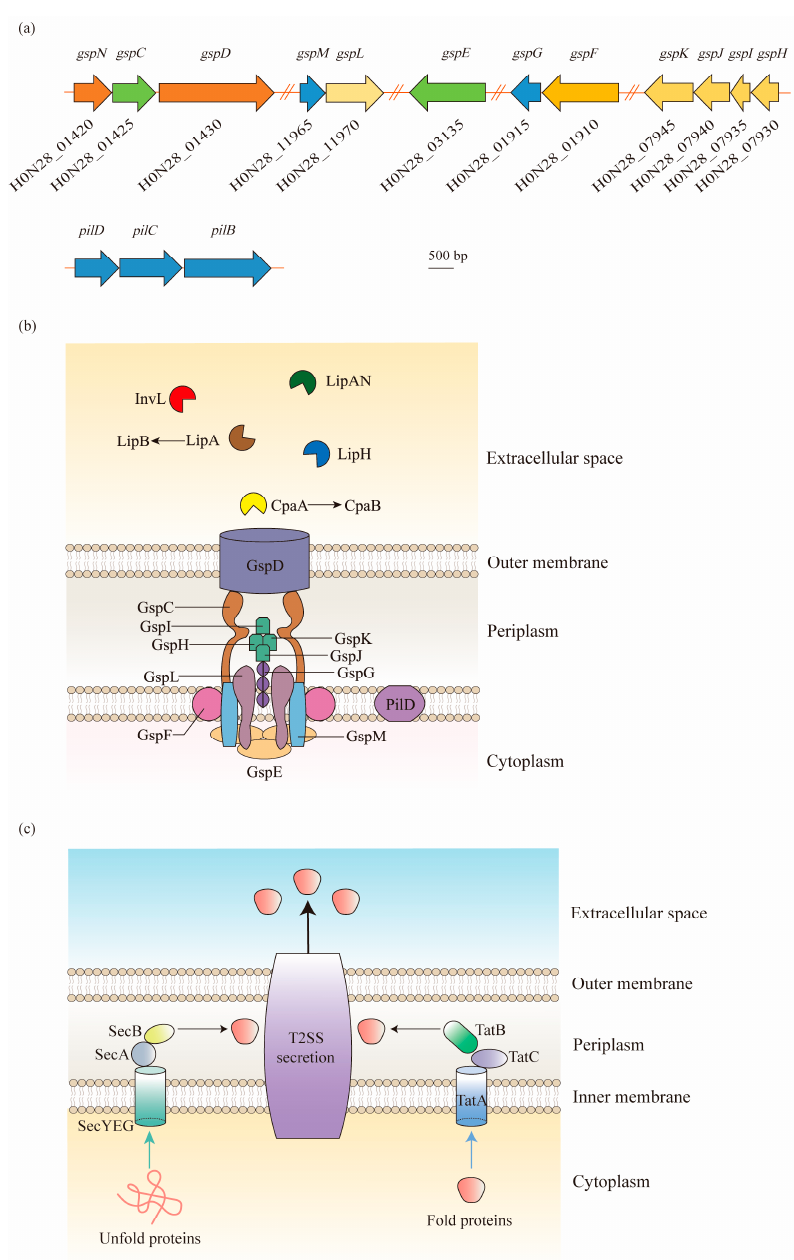
Figure 2. Type II secretion system (T2SS) structure of A. baumannii and its protein secretion mecha- nism: ( a ) As shown in the ATCC 17978 genome, the gsp genes required for the T2SS are located in five distant loci, and a single prepilin/pre-pseudopilin peptidase homolog is located in the pilBCD cluster. ( b ) The T2SS is composed of an outer membrane (OM) complex (GspD), a periplasmic pseudopilus (GspG, GspH, GspI, GspJ, and GspK), and an inner membrane (IM) platform (GspC, GspF, GspL, and GspM), which relates to the cytoplasmic ATPase GspE. In A. baumannii , the T2SS shares a processing protein, PilD, with type IV pili. The T2SS secretes a large number of effectors required for virulence, including the metallopeptidase CpaA (chaperone CpaB), the lipoyl synthases LipA (chaperone LipB), LipH, and LipAN, and a novel lipoprotein, InvL. ( c ) The T2SS-dependent proteins are first exported across the IM to the periplasm via the Sec or Tat pathways in A. baumannii . The Sec pathway primarily translocates unfolded proteins, relying on a hydrophobic signal sequence at the N-terminus. On the contrary, the Tat pathway, consisting of TatA, TatB, and TatC, primarily secretes folded proteins. Afterwards, the signal sequence is cleaved, followed by the folding of proteins. Finally, the folded proteins are expelled extracellularly through the OM